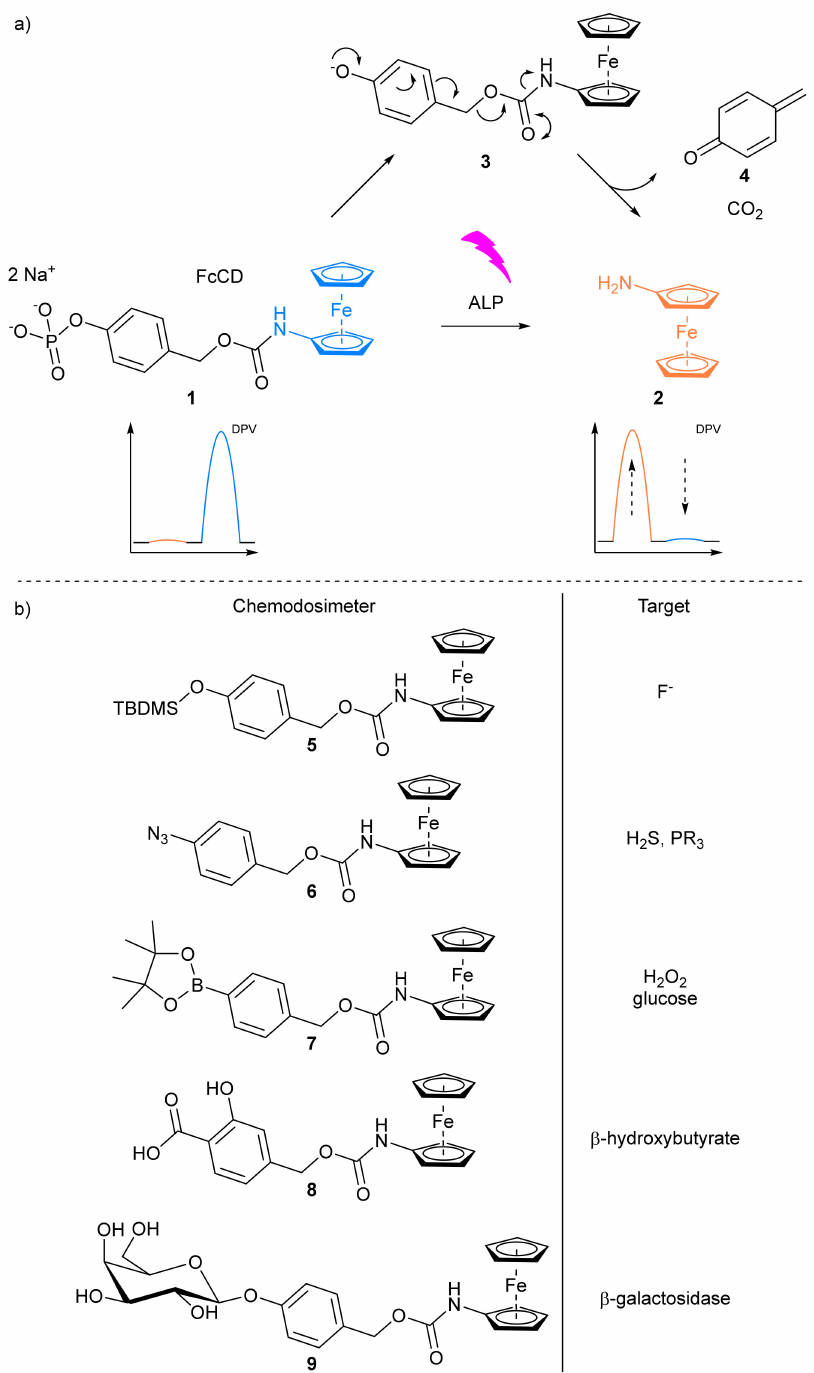
Figure 47. ( a ) Schematic representation of the ferrocene-based chemodosimeters for the detection of alkaline phosphatase (ALP); ( b ) selection of chemodosimeters and their